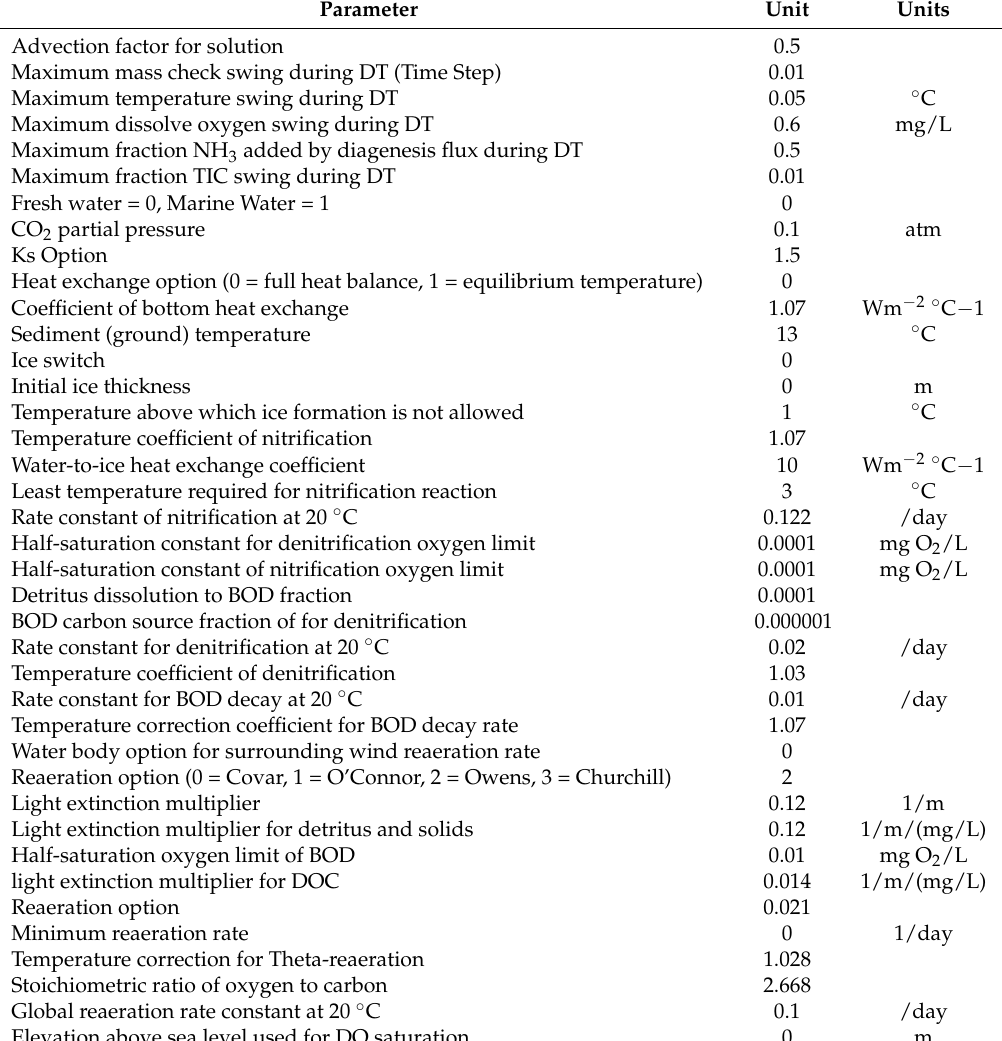
Table 3. Calibrated parameters for the WASP 8.1 model over the Ravi River in the Punjab, Pakistan.